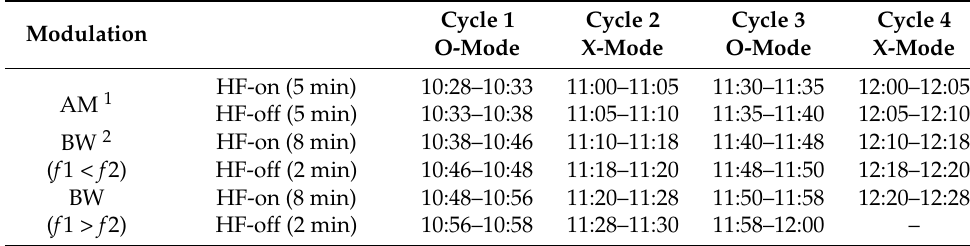
Table 1. Heating schedule on 21 November 2019.